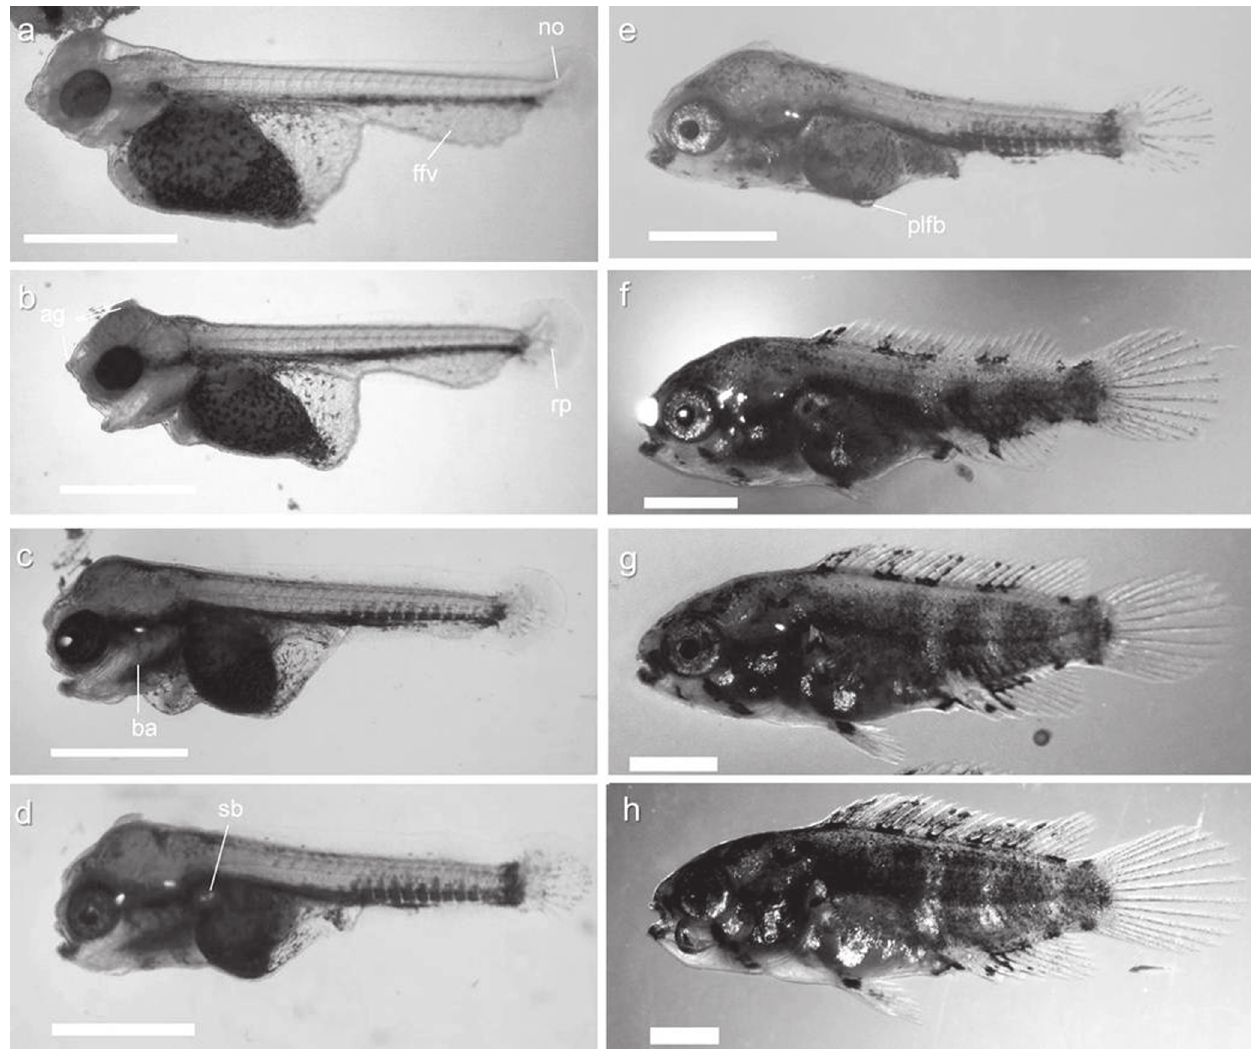
Fig. 2. Larval development of Nannacara annomala : (a) 0 DPH, days post hatch; (b) 1 DPH; (c) 2 DPH; (d) 3 DPH; (e) 5 DPH; (f) 7 DPH; (g) 10 DPH; (h) 15 DPH; (i) 18 DPH. Scale bars = 1 mm. ag, adhesive glands; ba, branchial arches; ffv, finfold